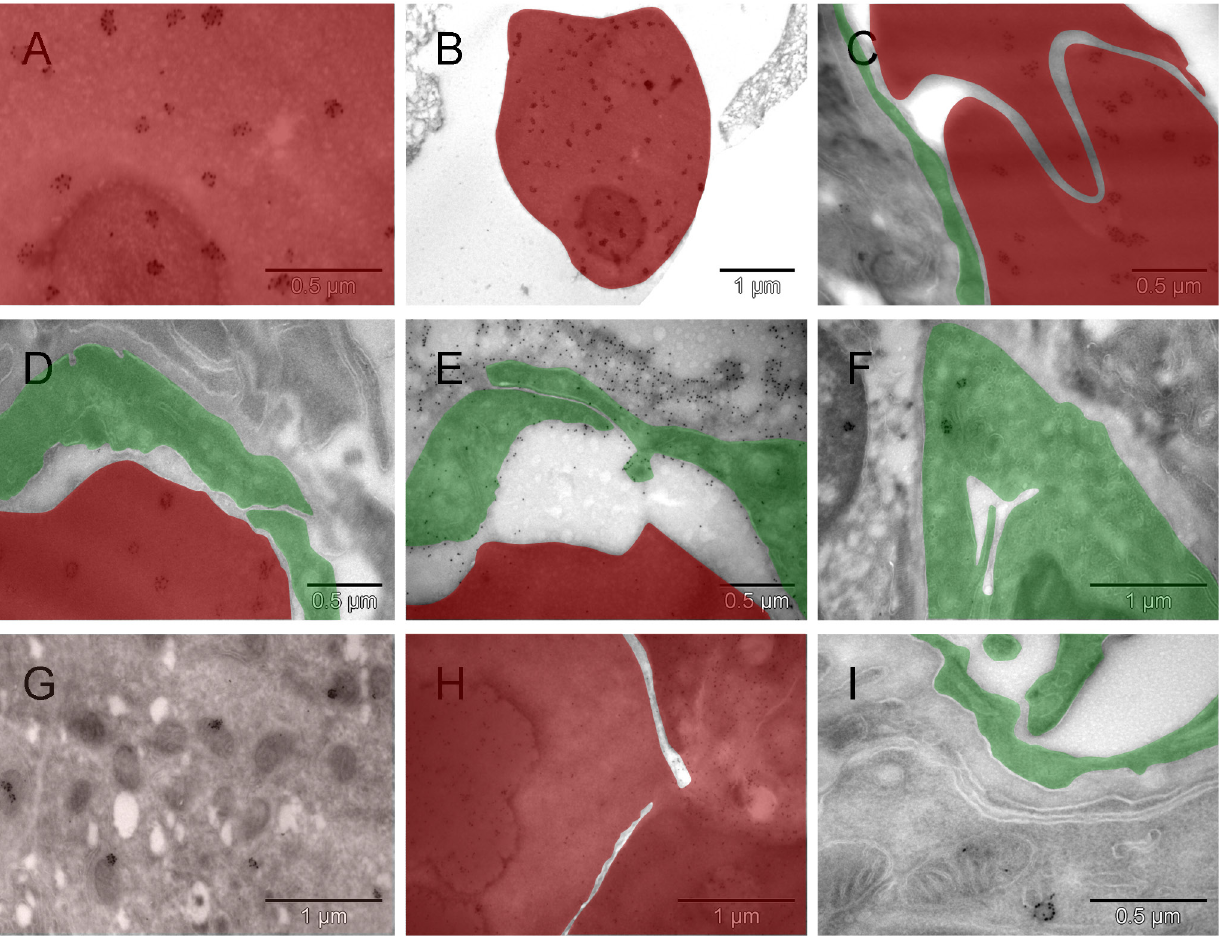
Figure S8. Calmyrite: a new ultrastructural entity involved in anaerobic metabolism. Uneven distribution of the abundant calmyrin- specific label in erythrosomes (red) from the solid tissue under the hyaline membrane was striking [ A , B , C & D ]. No such clusters were seen extracellularly [ E ]. The gold particles appeared arranged with certain symmetry in clusters of about 6 to 12, as if the protein became a part of distinct para-crystalline ultrastructures that in less differentiated regions were not formed ([ E ] and Figure S4). Such gold grain clusters were also present in ECs (green) [ F ] and tumor cells (brown) [ G ] where small dark mitochondria suggested hypoxic distress. In a giant cell, the uneven distribution of scattered calmyrin-specific label and heterogeneity of electron density indicated an ongoing process of erythrogenic conversion [ H ]. One calmyrite in a section from normal rat lung is shown in [ I ]. Those ultrastructural para-crystalline elements visualized by calmyrin-specific label are being described here for the first time and referred to as